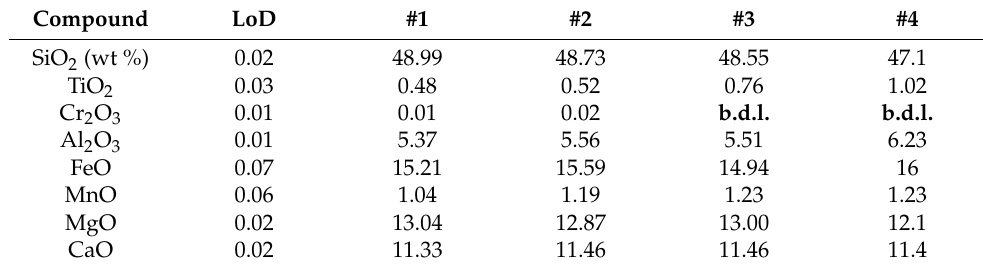
Table 2. Chemical composition and crystal-chemical formulae of amphiboles from the exotic mafic blocks from Osielec village (Magura